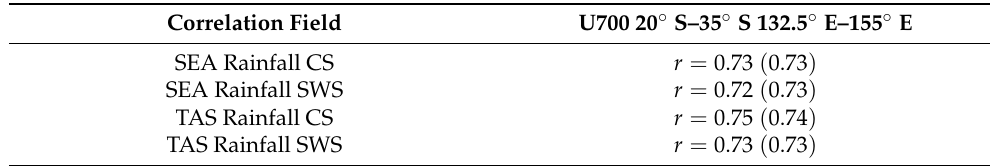
Table 8. Correlations ( r ) , and detrended correlations in brackets, of SEA and TAS Cool Season (CS) and Southern Wet Season (SWS) rainfall with 700 hPa zonal wind averaged between 20 ◦ S and 35 ◦ S, 132.5 ◦ E and 155 ◦ E. All confidence levels C L >